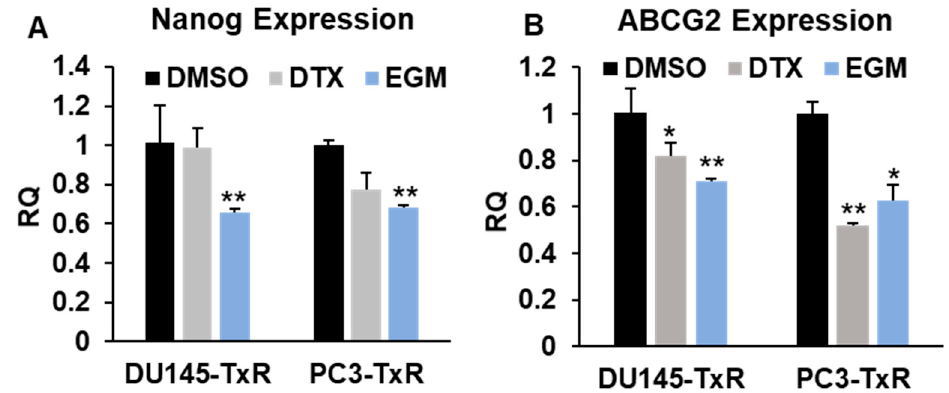
Figure 7. Eggmanone attenuates the expression of CSCs’ markers in chemo-resistant prostate cancer cells. ( A ) RT-PCR shows that mRNA of Nanog is statistically significantly down-regulated in chemo-resistant DU145-TxR and PC3-TxR cells treated with 3 µ M Eggmanone (EGM). ( B ) RT-PCR shows that mRNA of ABCG2 is statistically significantly decreased in chemo-resistant DU145-TxR and PC3-TxR cells treated with 3 µ M Eggmanone (EGM). RT-PC result was represented as mean relative quantity (RQ) ± SEM ( n = 3, * p < 0.05, ** p <